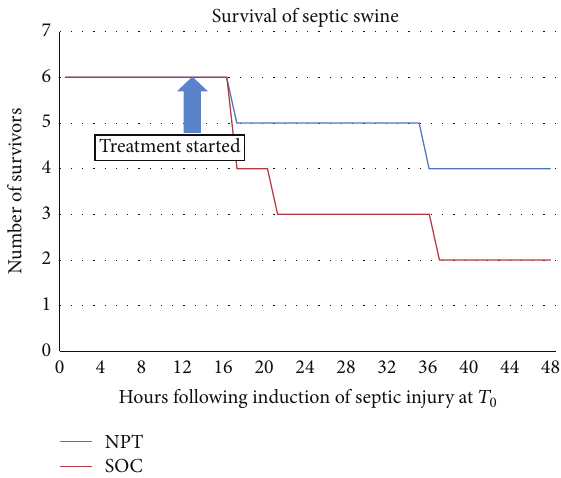
Figure 1: Survival rate of septic swine. The number of septic swine that survived the experimental period was determined for each treatment group. The mortality in the SOC group (4/6) was twice that of the NPT group (2/6). The Odds ratio was 4.0, indicating that survivalwas4timeshigherintheNPTgroupthanintheSOCgroup.